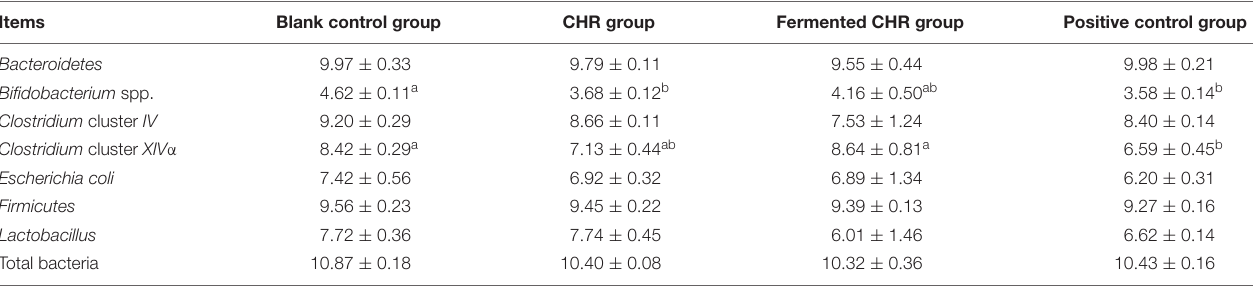
TABLE 5 | Effects of dietary supplementation with Chinese herbal residues (CHR) or fermented CHR on colonic microbiota quantities in weaned piglets ( n = 5; lg copies/g).